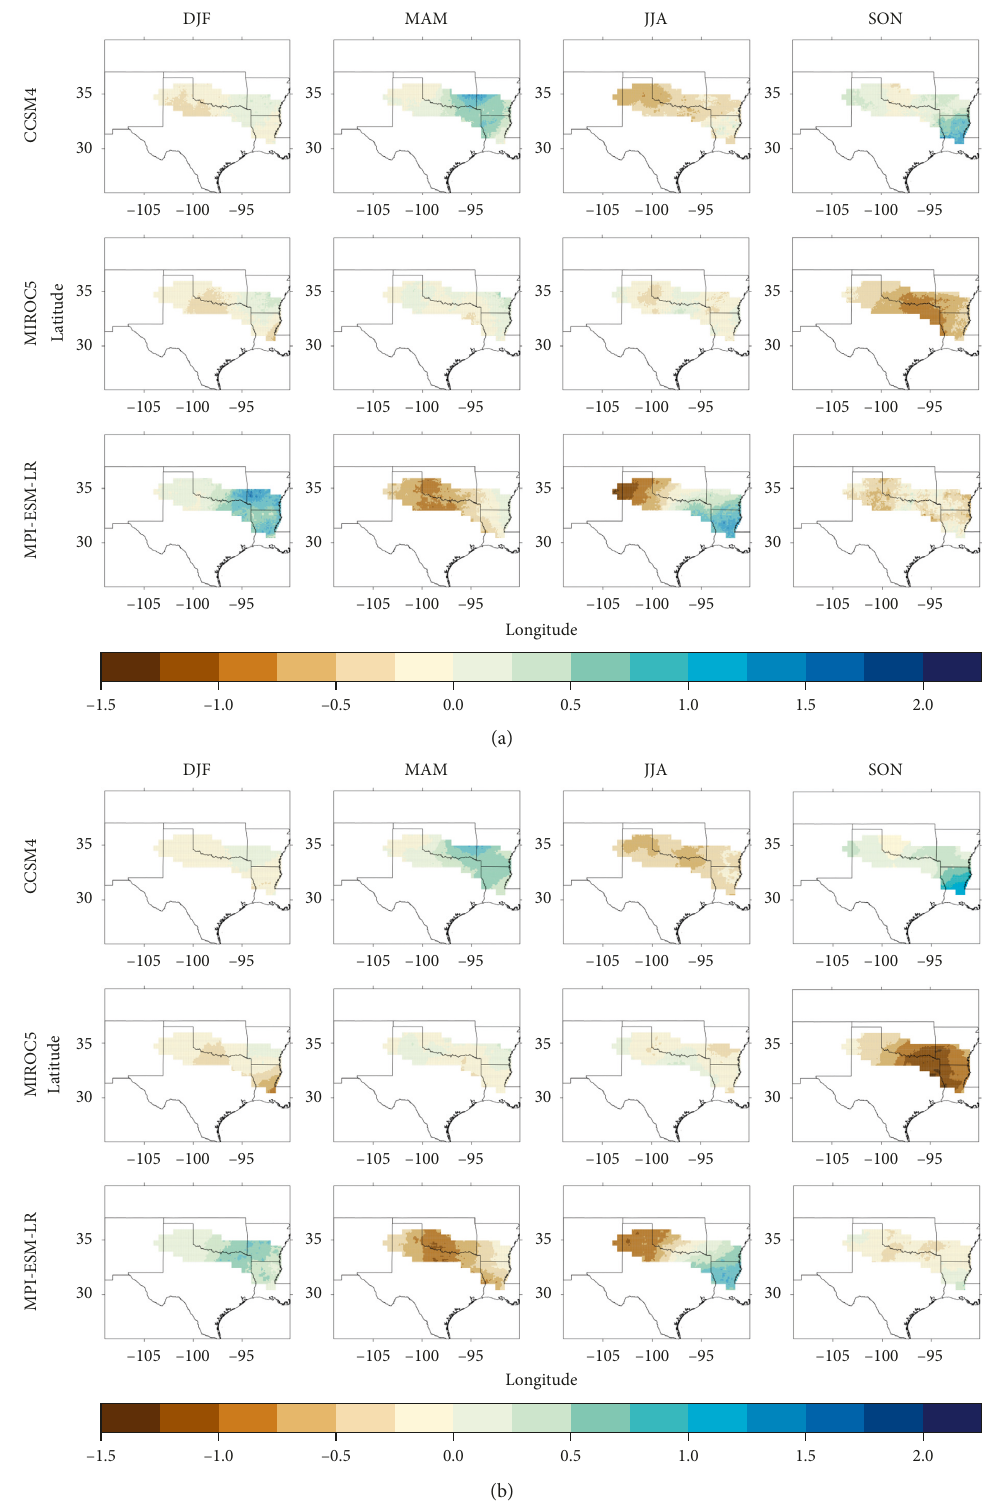
Figure 9: Difference fields in seasonal changes in mean daily precipitation (mm/day) between the historical (1981–2005) and end-of-century (2075–2099) time frames for RCP 8.5 using the (a) CDFt downscaling technique and (b) EDQM technique. Columns represent seasons (DJF, MAM, JJA, and SON). Brown colors represent a decrease in daily precipitation and blues represent an